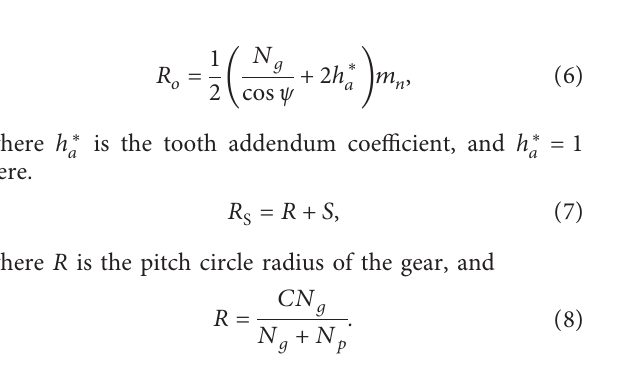
Figure 1: Layout parameters of gear